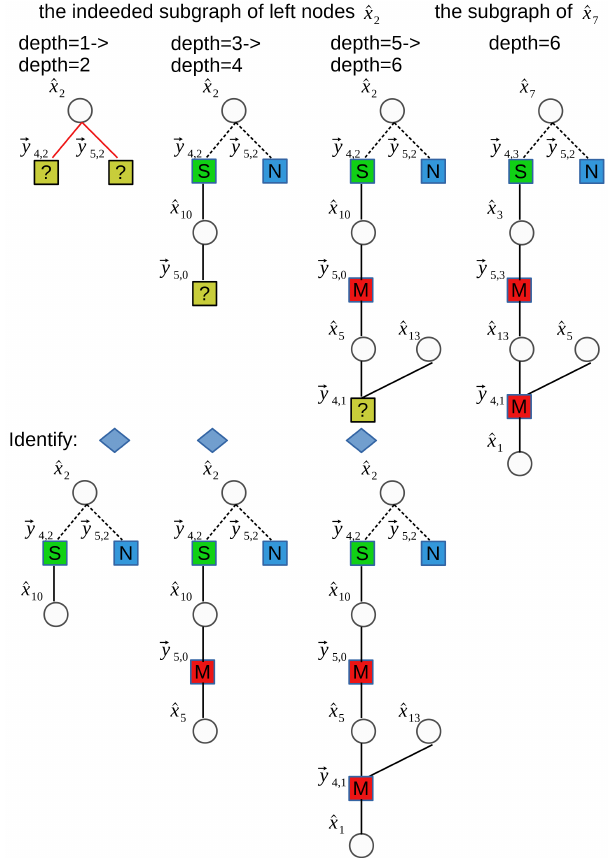
Figure 5. Example of the process of the sparse-graph decoder by the packet erasure channel method. In the process of expanding the subgraph of ˆ x 2 , when the depth is equal to two, one “zero-ton” and one “single-ton” are distinguished; when the depth is equal to four, one “multi-ton” is distinguished; when the depth is equal to six, one “multi-ton” is distinguished. In the process of expanding the subgraph of ˆ x 7 , one “zero-ton”, one “single-ton”, and two “multi-ton”s are distinguished.